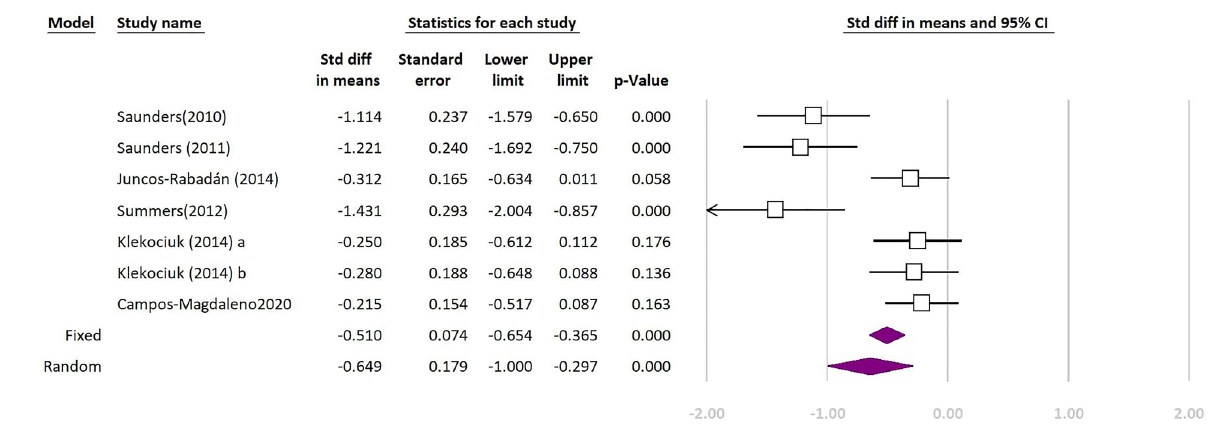
Figure 3. Meta-analysis of comparing patients with mild cognitive impairment and healthy controls based on “length” measure of spatial span (SSP) test of Cambridge Neuropsychological Test Automated Battery. The purple indicator is the final result. (Test for heterogeneity: I 2 : 82.76%; p<0.01).